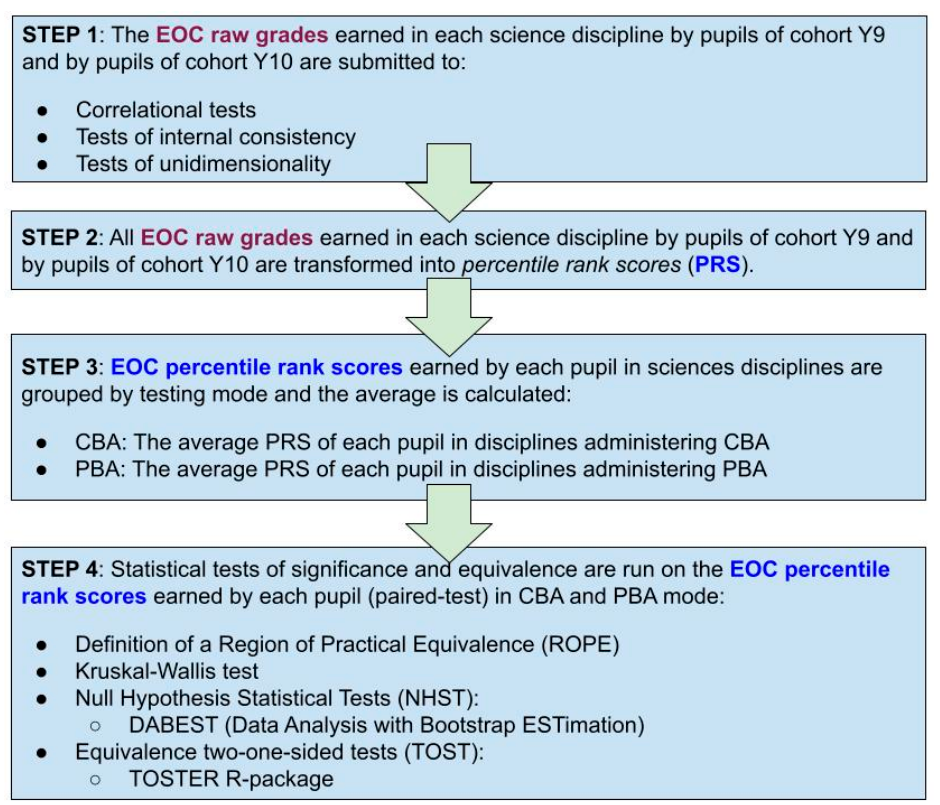
Figure 1. A diagram of the four steps of our methodological approach.